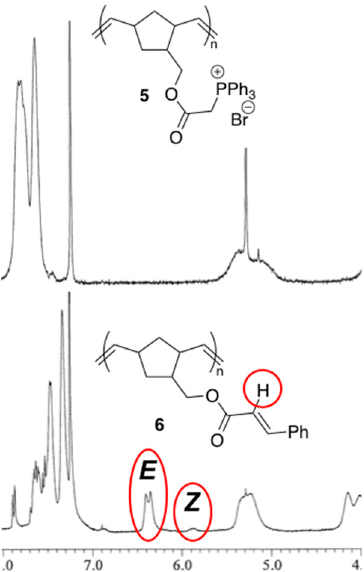
Figure 1. Photographs of crude, partial 1 H NMR spectra of 5 (top) and 6 (bottom) showing the chemical shifts of the indicated protons for 6 .